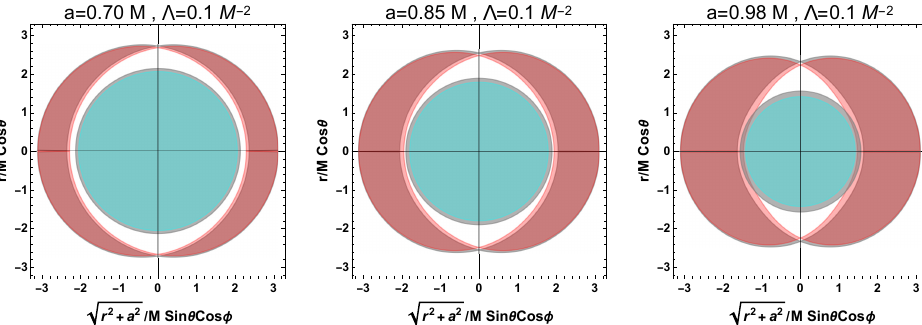
Figure 5. A comparison of the cross-section of the event horizon (blue shaded region) and photon region (pink shaded region) for the two Kerr–de Sitter black holes. The lighter regions correspond to the new Kerr–de Sitter black holes, whereas the darker regions correspond to the Kerr–de Sitter black holes